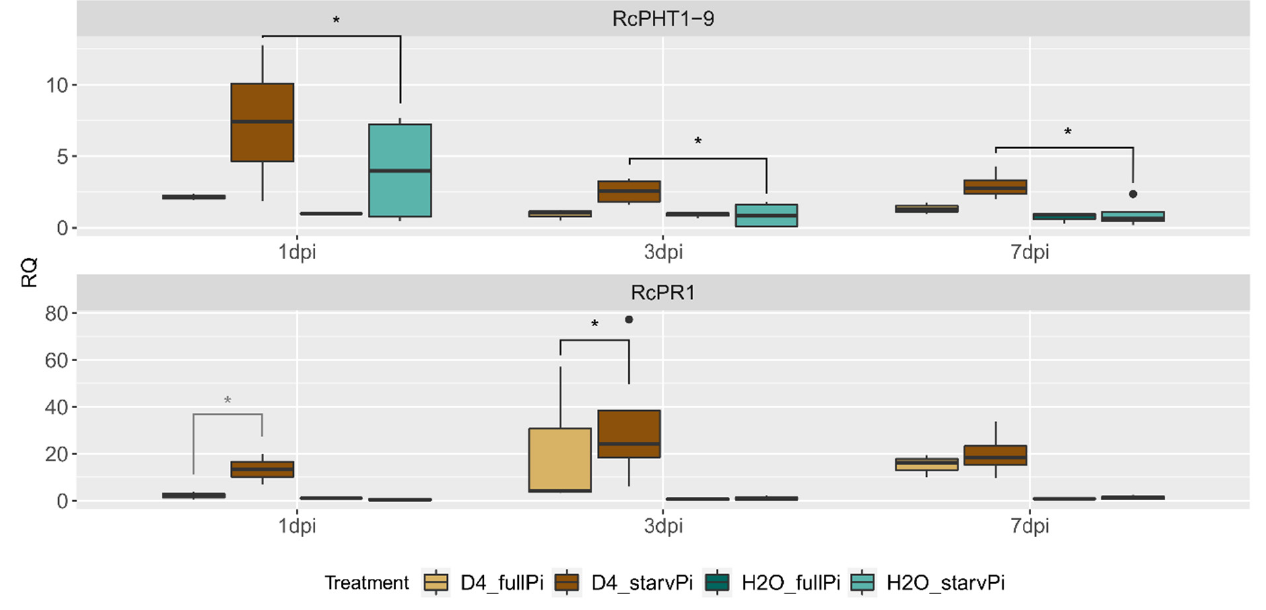
Figure 8. RT-qPCR analysis of a combined stress experiment in leaves of rose genotype s_104 at one, three, and seven dpi. Two Pi treatments (“fullPi” and “starvPi”) and additional inoculation with D. rosae (“D4”). Expression changes relative to “H 2 O_fullPi” at each time point. Data are represented as boxplots of RQ values (relative quantification = 2 − ∆∆ Ct ) and some significant comparisons are marked by asterisks (in grey because of n = 2), n = 4.